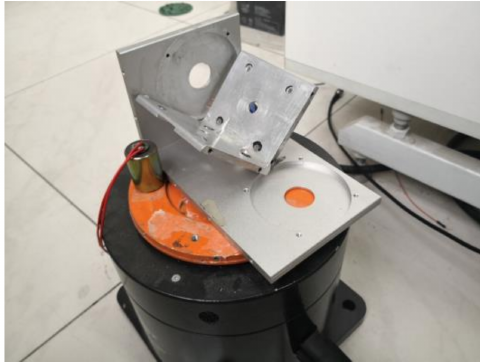
Figure 7. The schematic of the home-developed framework.